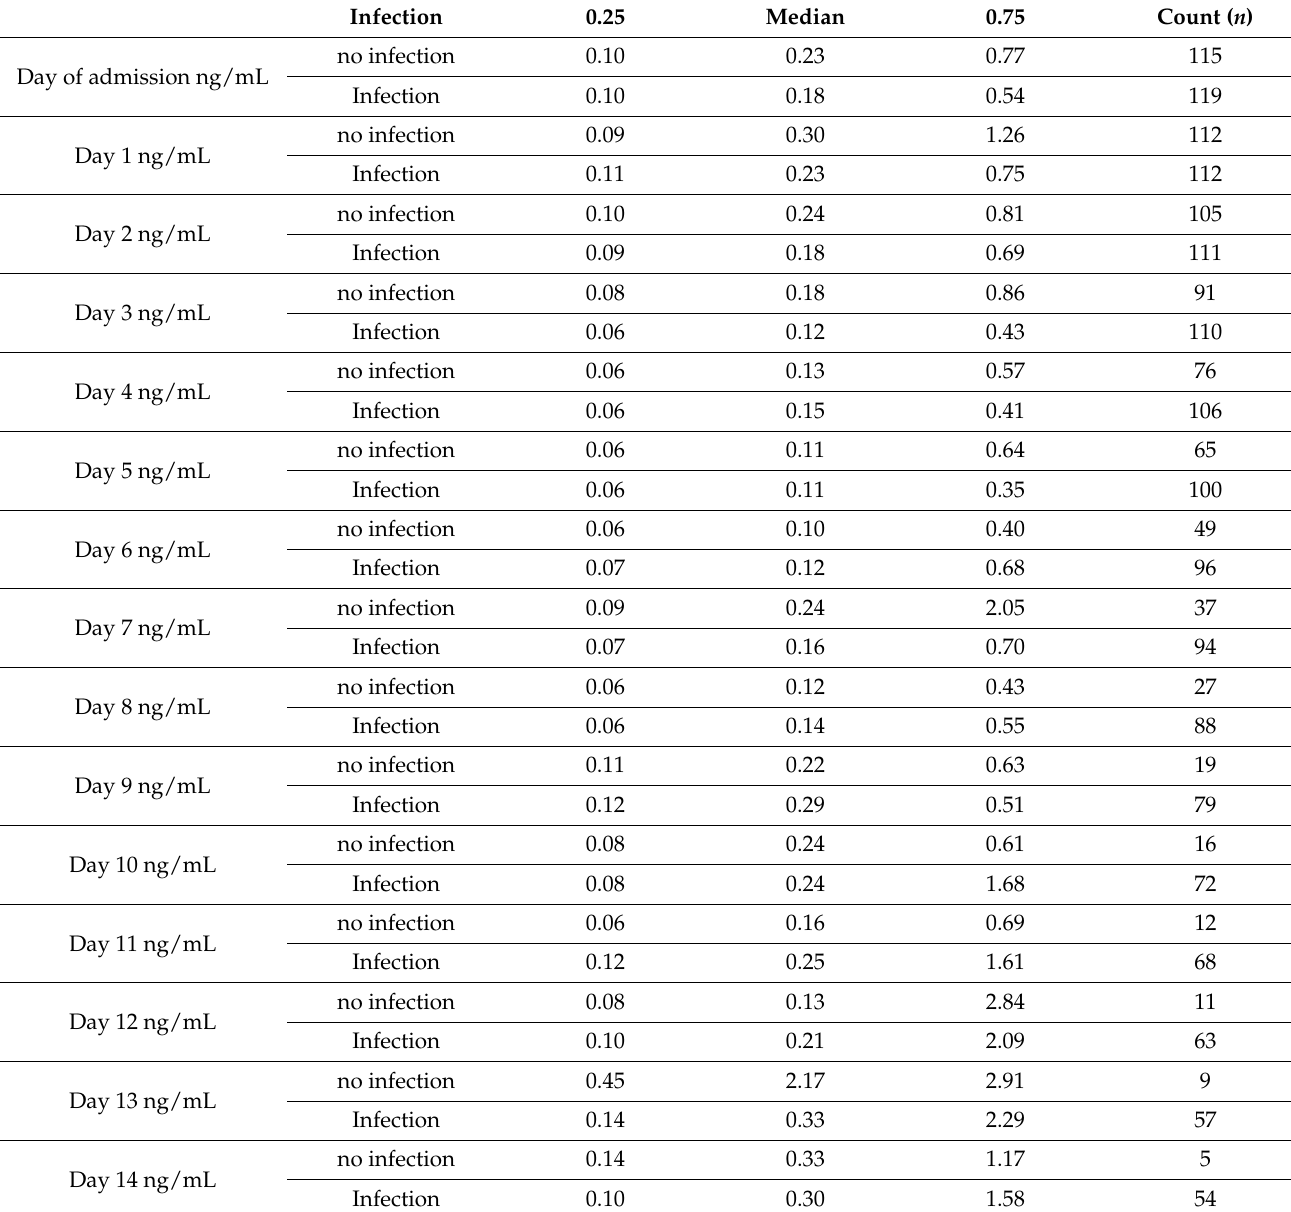
Table 2. Median, Q1 (0.25), and Q3 (0.75) Procalcitonin (PCT) Values from Day 0 (PCT 0) to Day 14 (PCT 14) in those who had an infection and those who did